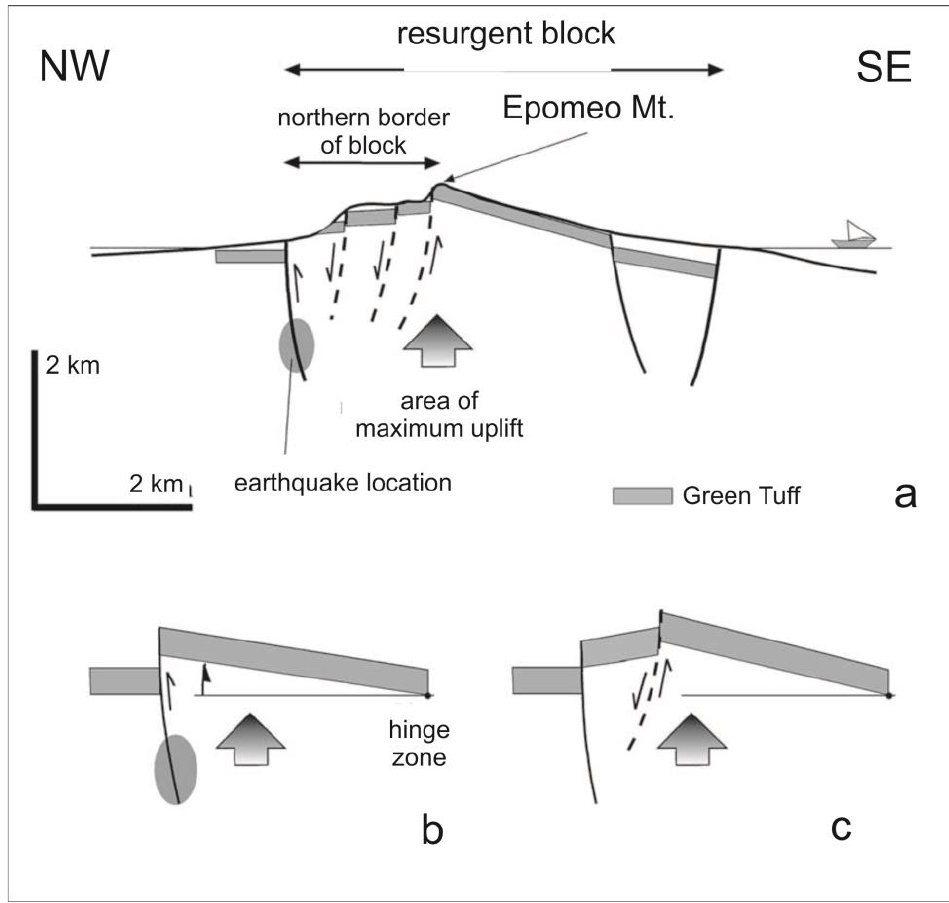
Figure 7. Model for the uplift of the Ischia resurgence (modified after Molin et al. [52]) ( a ) Sketch diagram showing the actual tectonic setting, with the asymmetric block bordered by high-angle inward-dipping reverse faults, and outward-dipping normal faults in the innermost part. ( b ) Sketch diagram showing the model of the intermittent trapdoor uplift, with the seismic activity controlled by the reverse faults on the most strained side of the block. ( c ) Sketch diagram showing the model of the intermittent trapdoor uplift, with the activity of the reverse fault controlling the collapse of the periphery of the block and forming the outward-dipping normal faults.